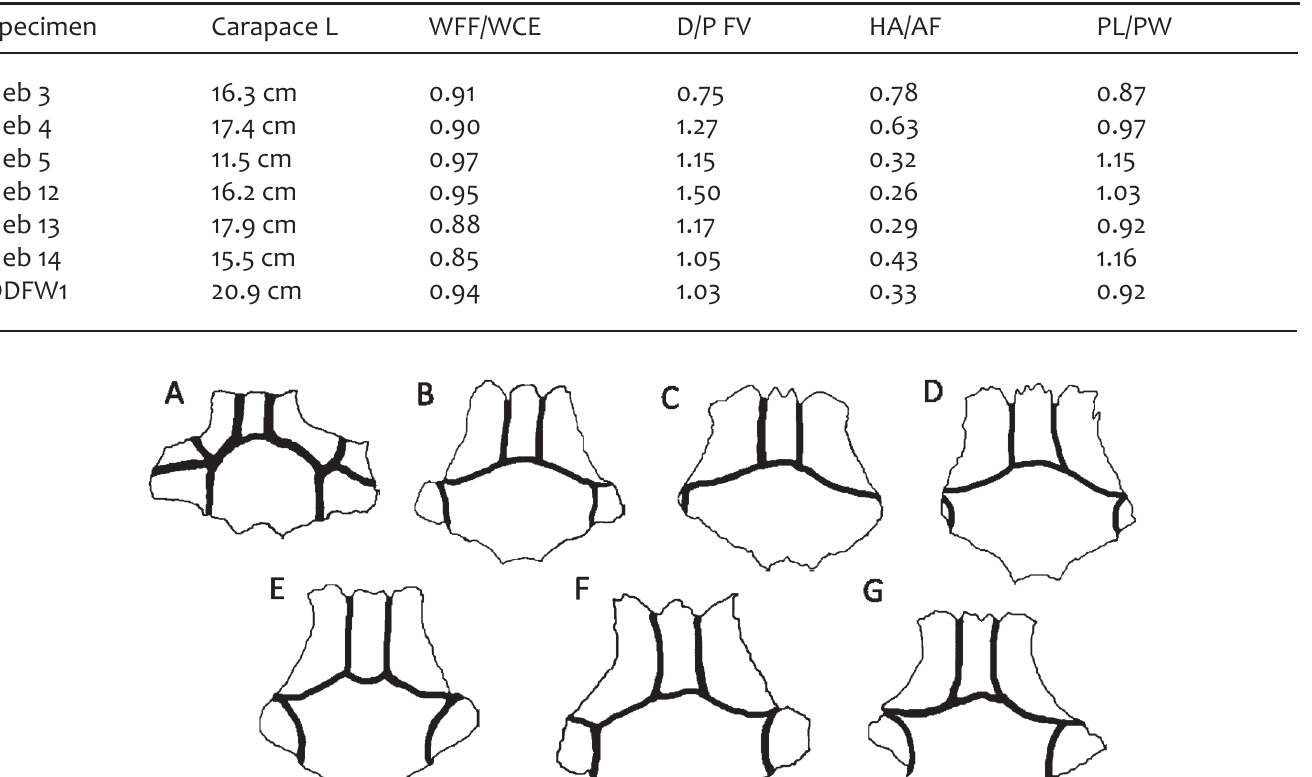
Table 1. Morphometric variation of shell characters. Abbreviations: L, length of carapace in centimeters; WFF, carapace width at margin where the fourth and fifth marginal scutes meet; WCE, carapace width at midpoint of the eighth marginal scute; D FV, distal width of first vertebral scute; P FV, proximal width of first vertebral scute; HA, distance between humeral/ abdominal sulcus and the hyo/hypoplastral suture at the midline; AF, distance between the abdominal/femoral sulcus and the hyo/hypoplastral suture at the midline; PL, pygal length at the midpoint; PW, pygal width at the midpoint.